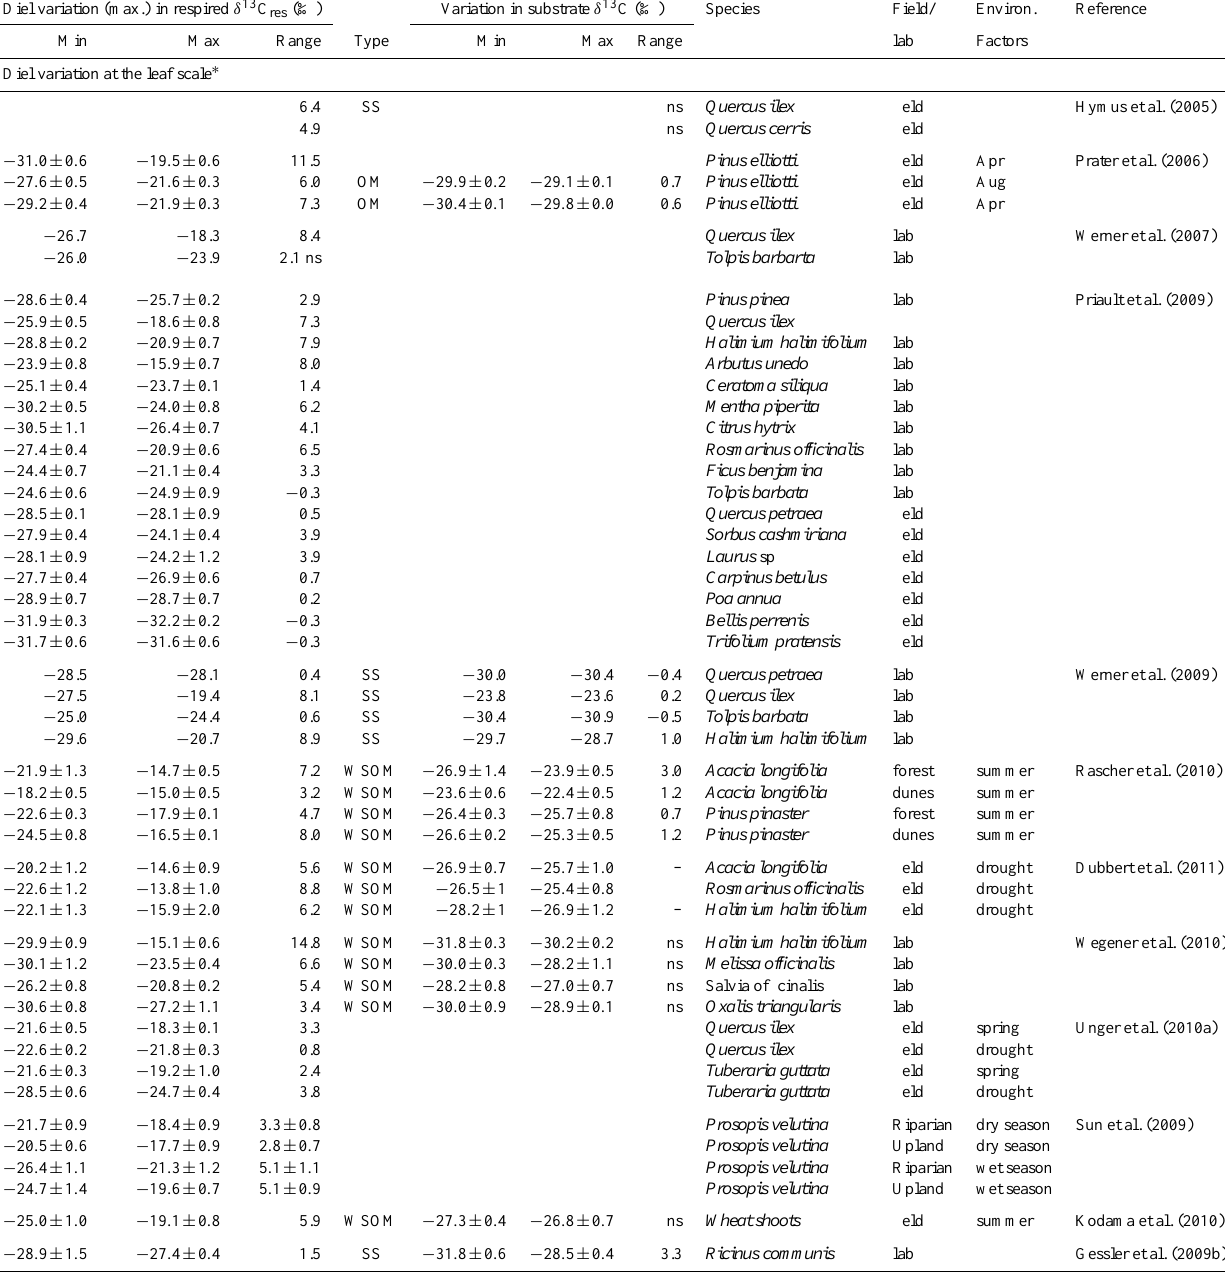
Table 1. Survey of diel variations in respired δ 13 C res of leaves, roots, trunks, soil and ecosystem respiration (minimum, maximum and total range within 24h) and the variation of the putative substrate (glucose (Glu), soluble sugars (SS), sucrose (Suc); water soluble organic mater (WSOM); bulk organic matter (OM)). The species, growing conditions (field or controlled laboratory conditions (lab)), environmental factors and references are given; ns – not significant; – not